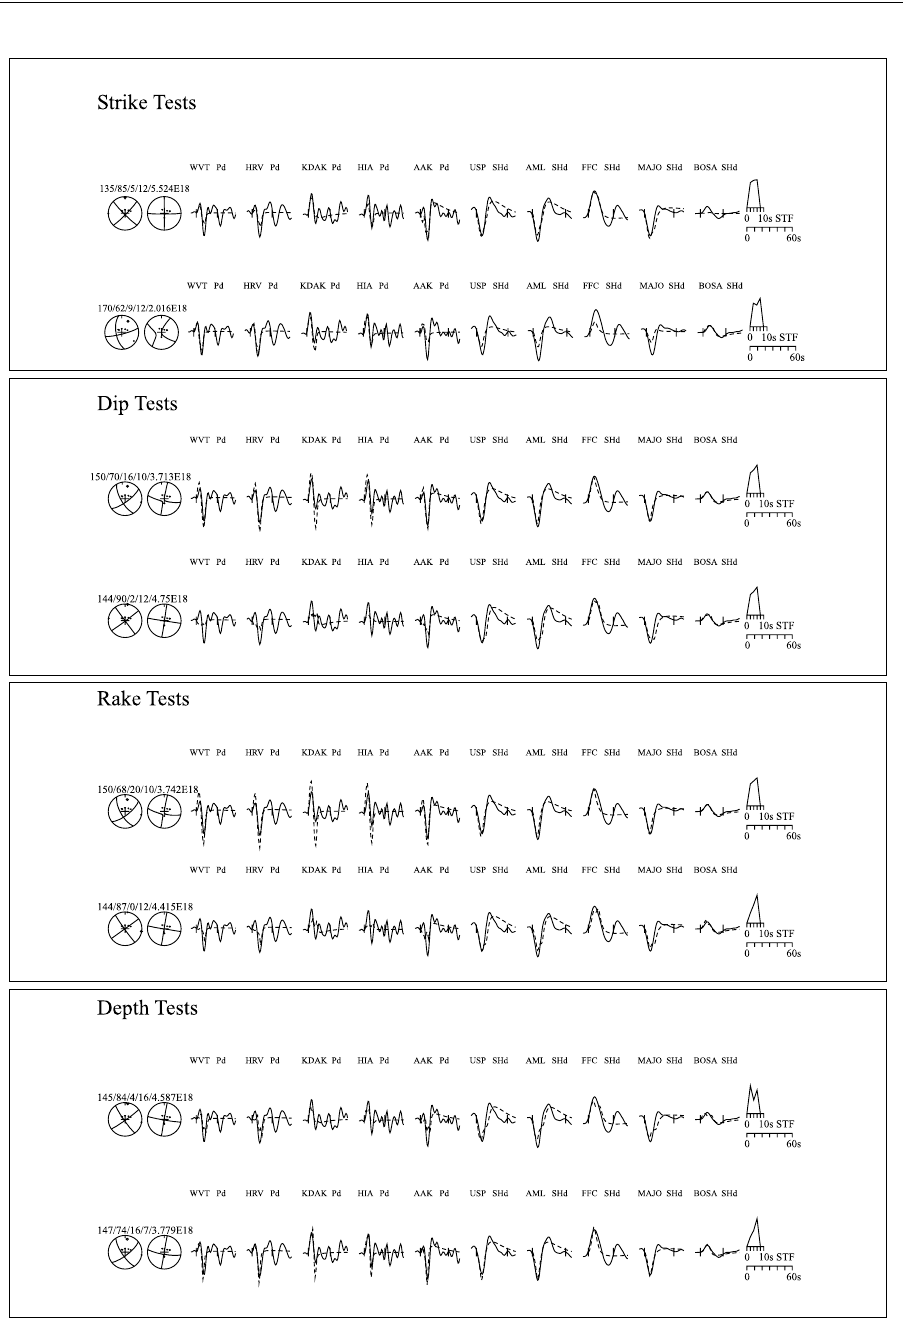
Fig. 4. Presentation of the tests performed in order to define the uncertainties in strike, dip, rake and depth (as discussed in the text and listed in table